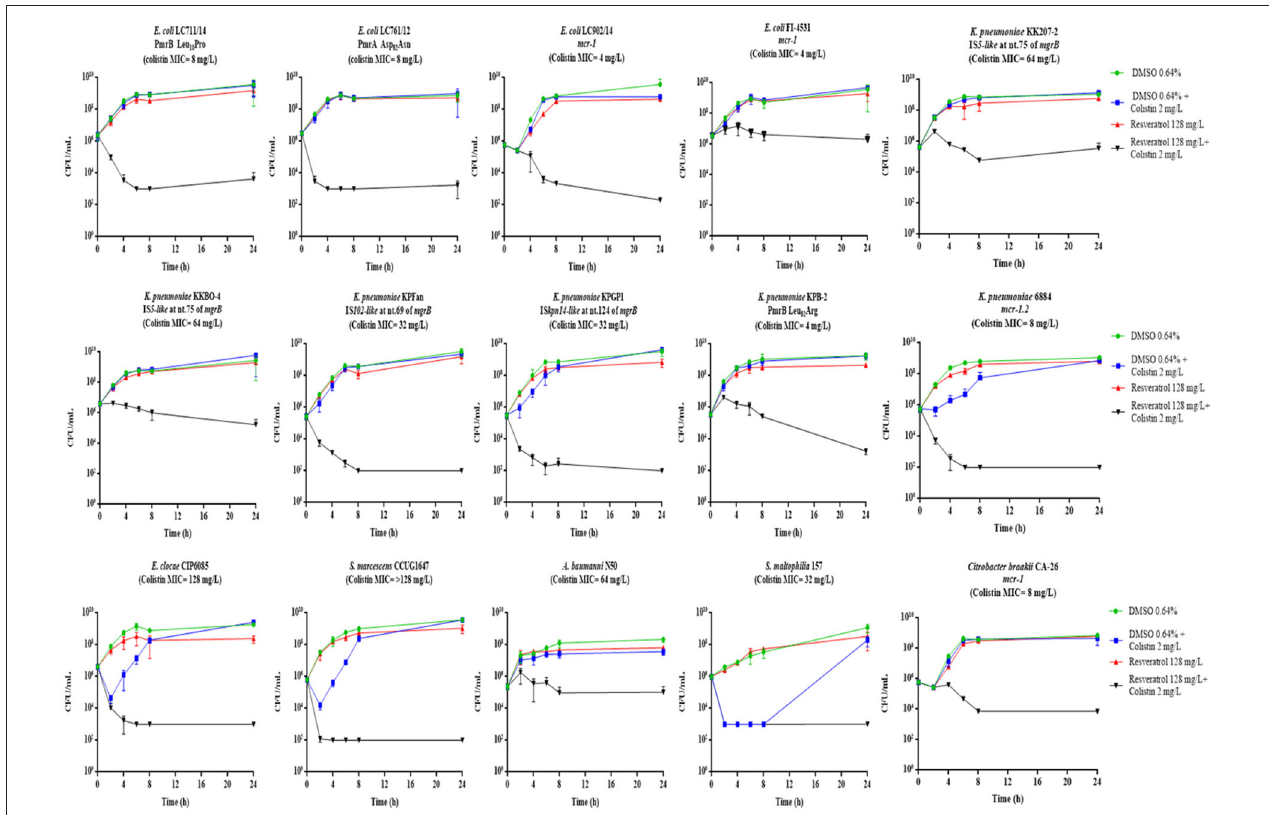
FIGURE 1 | Time-kill assays with colistin 2 mg/L in combination with resveratrol 128 mg/L. Data are mean values from the results of two independent experiments, and the error bars represent standard deviations. The lowest number of CFU (detection limit) that can be detected by the method used is 1E + 02 CFU/mL.